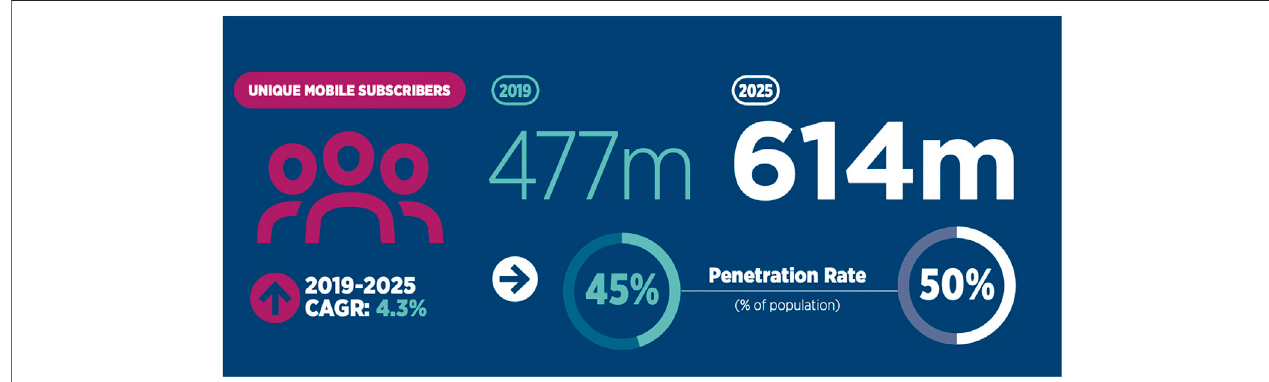
FIGURE 3 | Sub-Saharan mobile subscribers [GSMA Intelligence (Intelligence, 2020)].